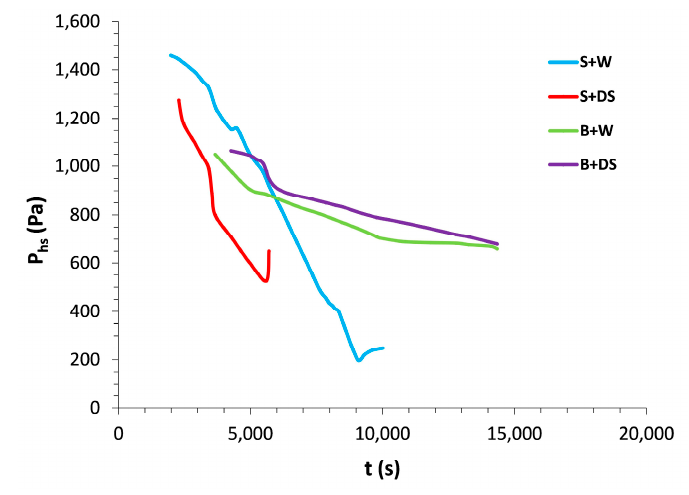
Figure 14. Hydrostatic pressure in the porous media.